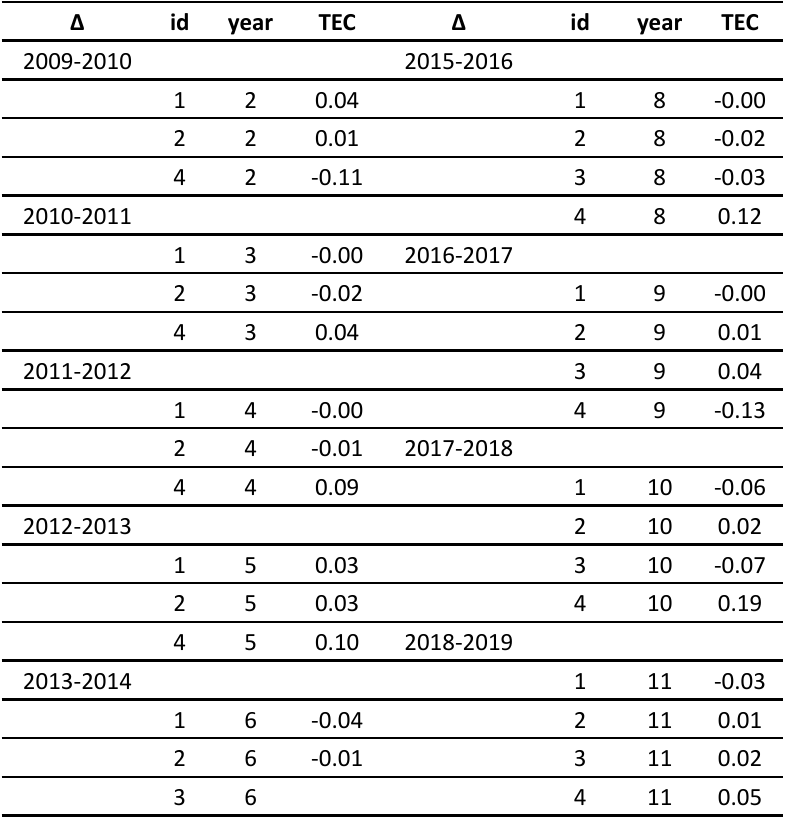
Table 5: Technical Efficiency Change in Container Terminals in Tanjung Perak Δ